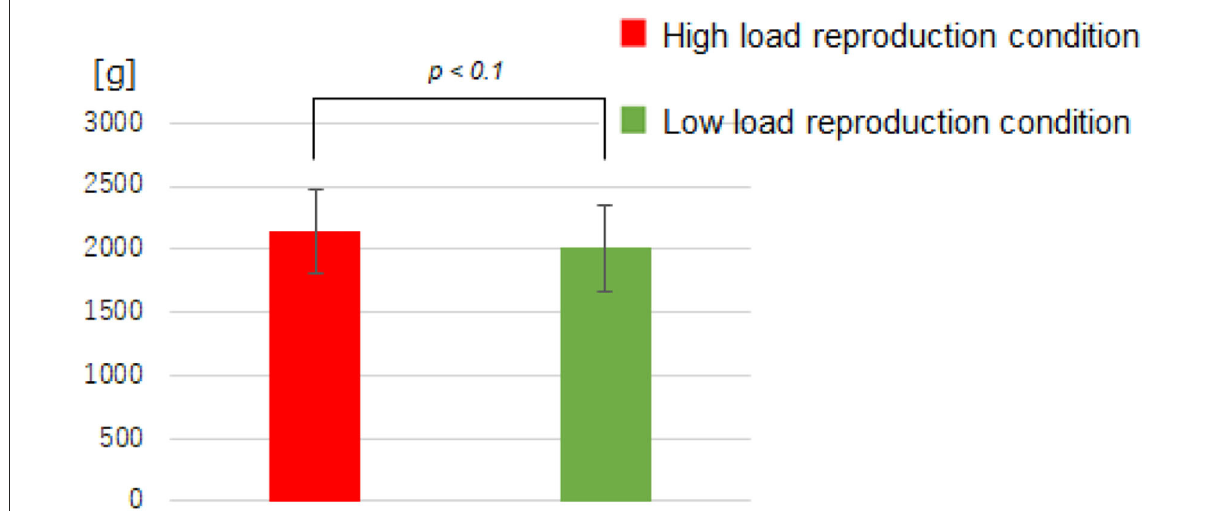
FIGURE5 Results of Experiment 1. The average value of the weight perception for each condition (Futami et al., 2021a).